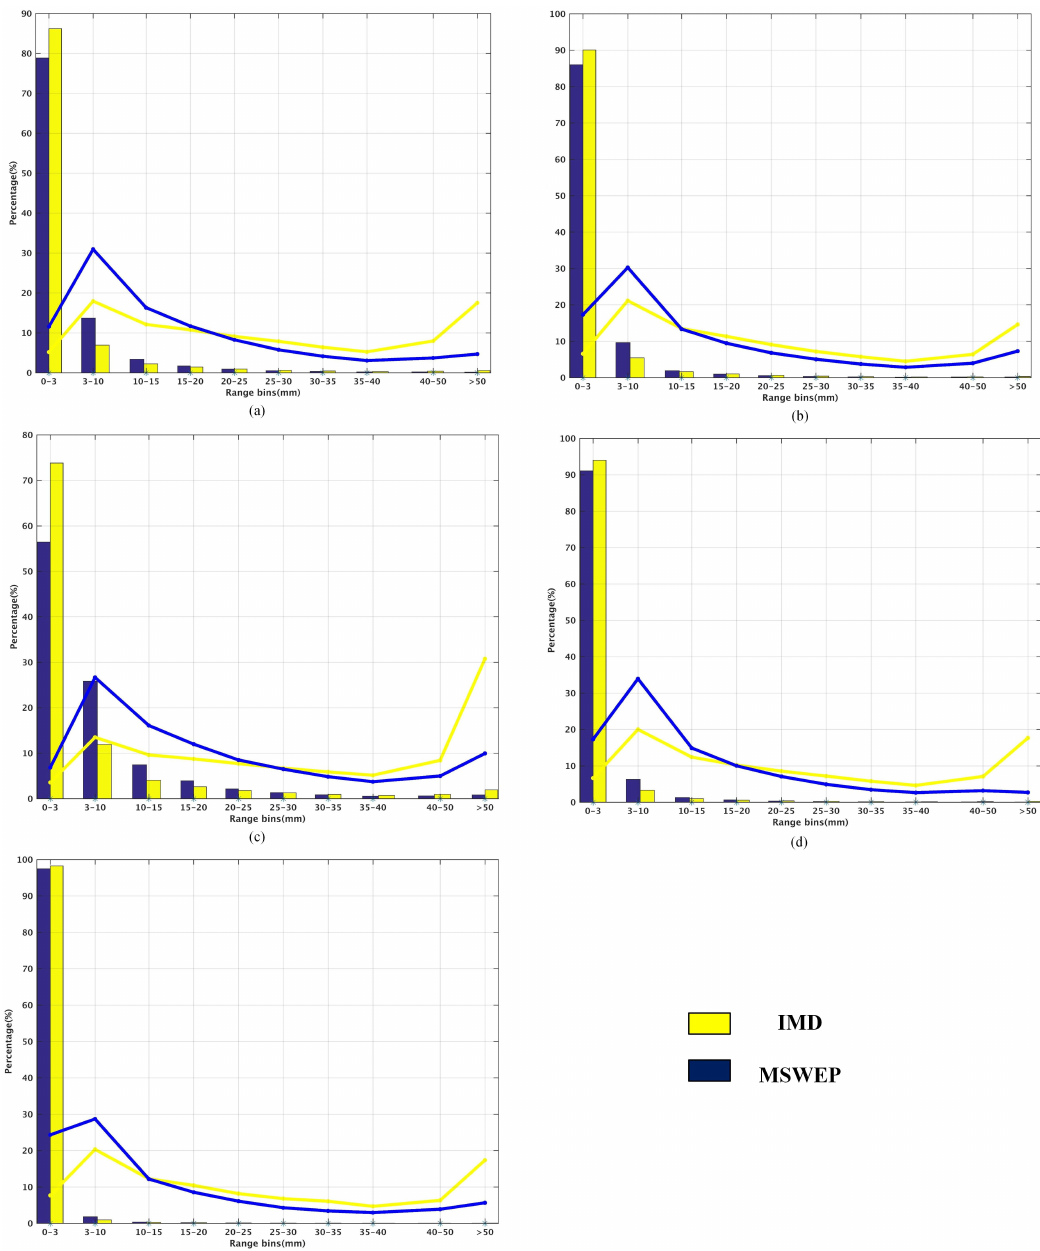
Figure 6. Distribution of daily rainfall in different rainfall classes and their relative contributions to the total rainfall in different grids for the post-monsoon season (October and November) (ON): ( a ) all India; ( b ) southwest India; ( c ) southeast India; ( d ) central India; ( e ) northwest India. Further, the statistical parameters of all India and its subregions’ daily climatological rainfall for the analysis period (1979–2013) have been tabulated in Table 3. The spatial average of the climatological mean rainfall over all India, southwest, southeast, central, and northwest, is 3.135 mm/day, 3.501 mm/day, 2.408 mm/day, 3.114 mm/day, and 1.372 mm/day, respectively, from IMD reference observations; that from MSWEP is 3.31 mm/day, 3.234 mm/day, 2.639 mm/day, 3.358 mm/day, and 1.530 mm/day, respectively. This shows that the spatial average of climatological mean from MSWEP is in accordance with the IMD rain gauge observations over the heavy/moderate rainfall regions of southwest/central regions and with low/less rainfall occurring northwest/southeast